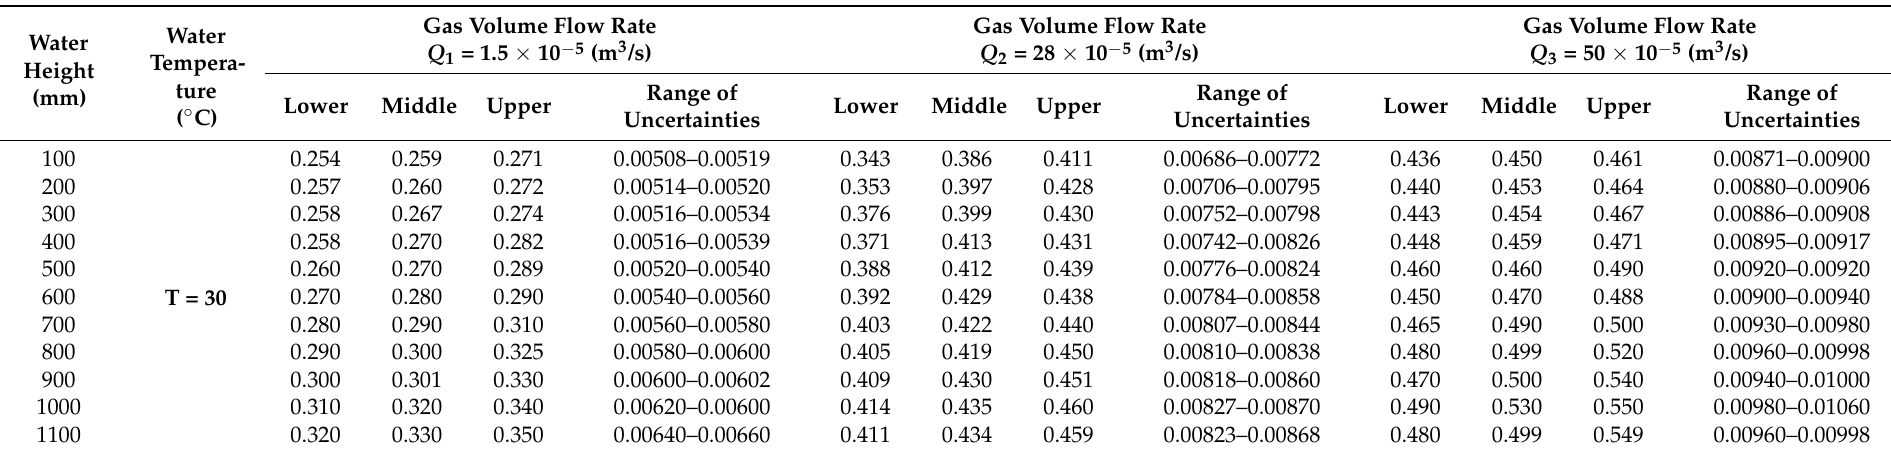
Table 7. Bubble speed (m/s) as a function of water height for T = 30 ◦ C and for gas volume flow rates Q 1 –Q 3